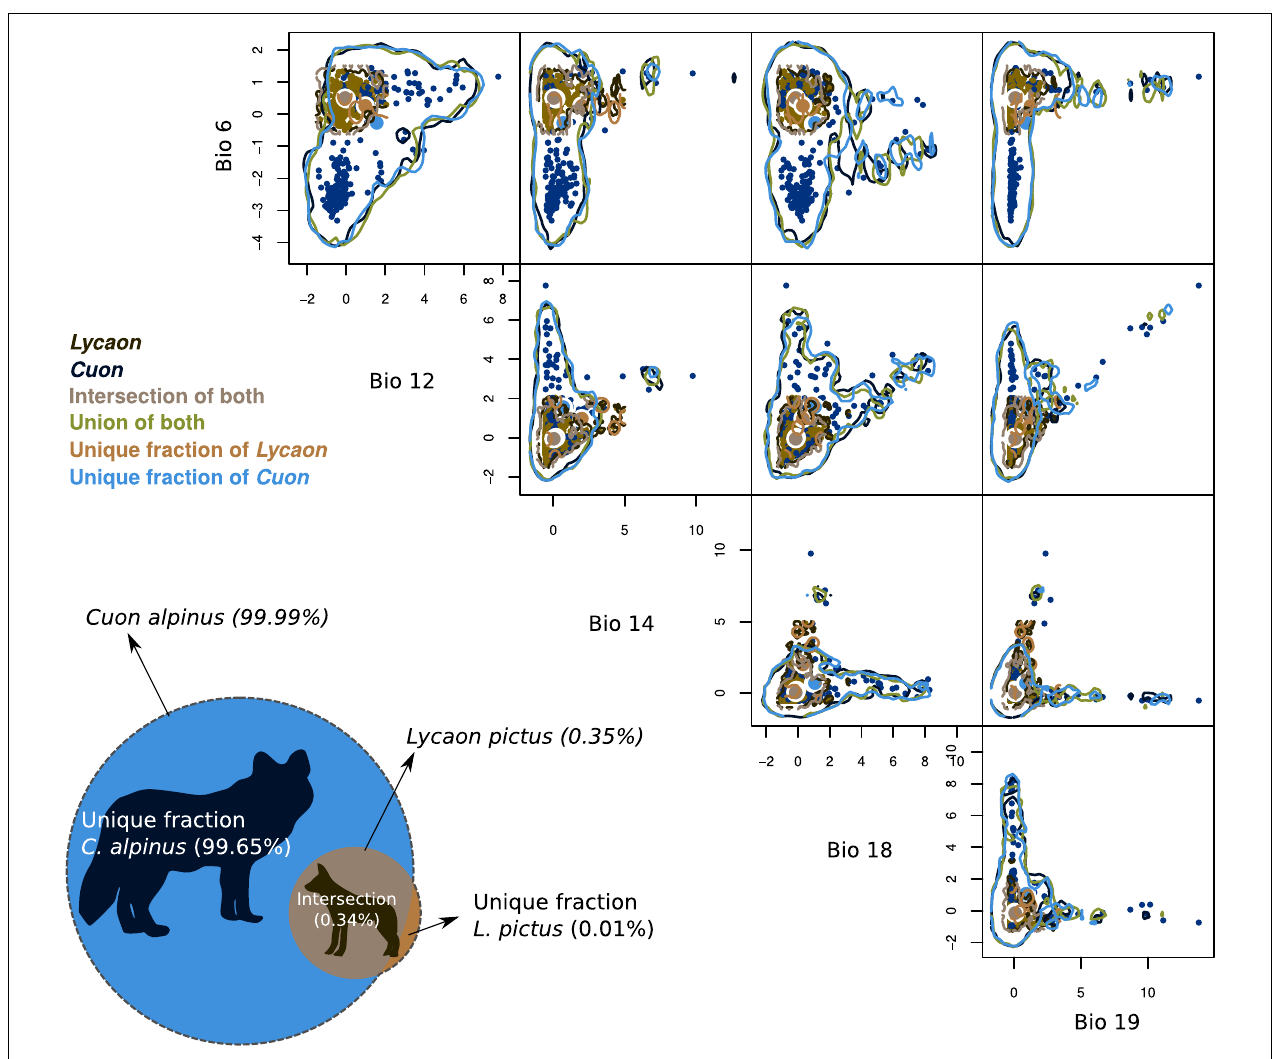
FIGURE 2 | Niche hypervolumes for the dhole ( Cuon alpinus ) and the African wild dog ( Lycaon pictus ) shown as 2D projections for all combinations of the 5 bioclimatic variables (Bio 6, Bio 12, Bio 14, Bio 18, Bio 19) and as a Venn diagram including percentages of unique fractions and intersection of species’s